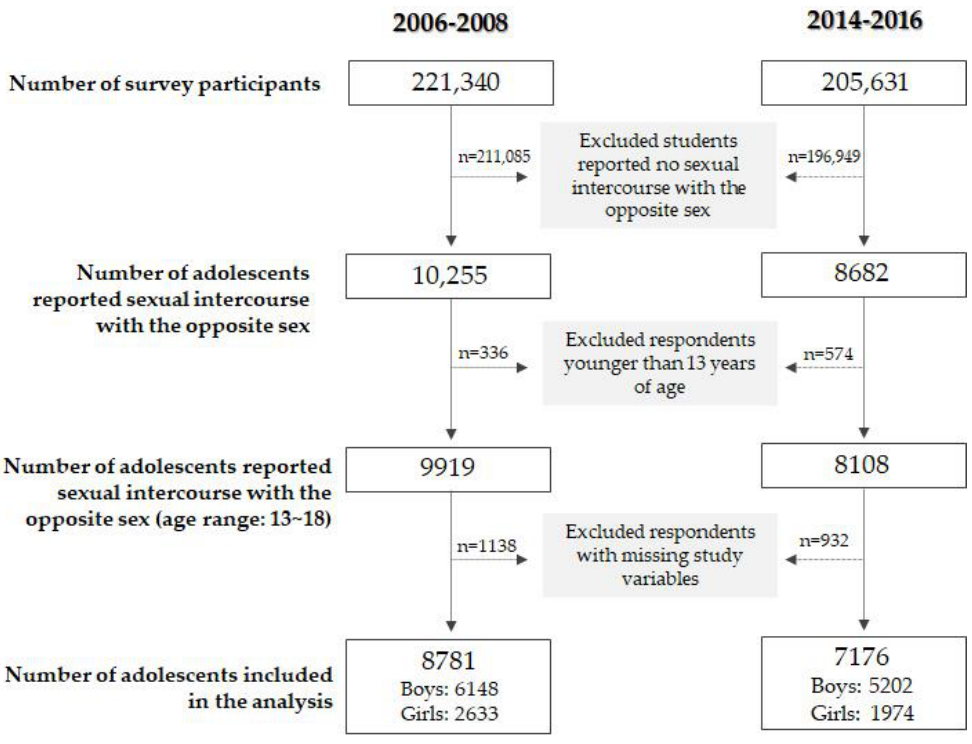
Figure 1. Selection process of study subjects included in the analysis.